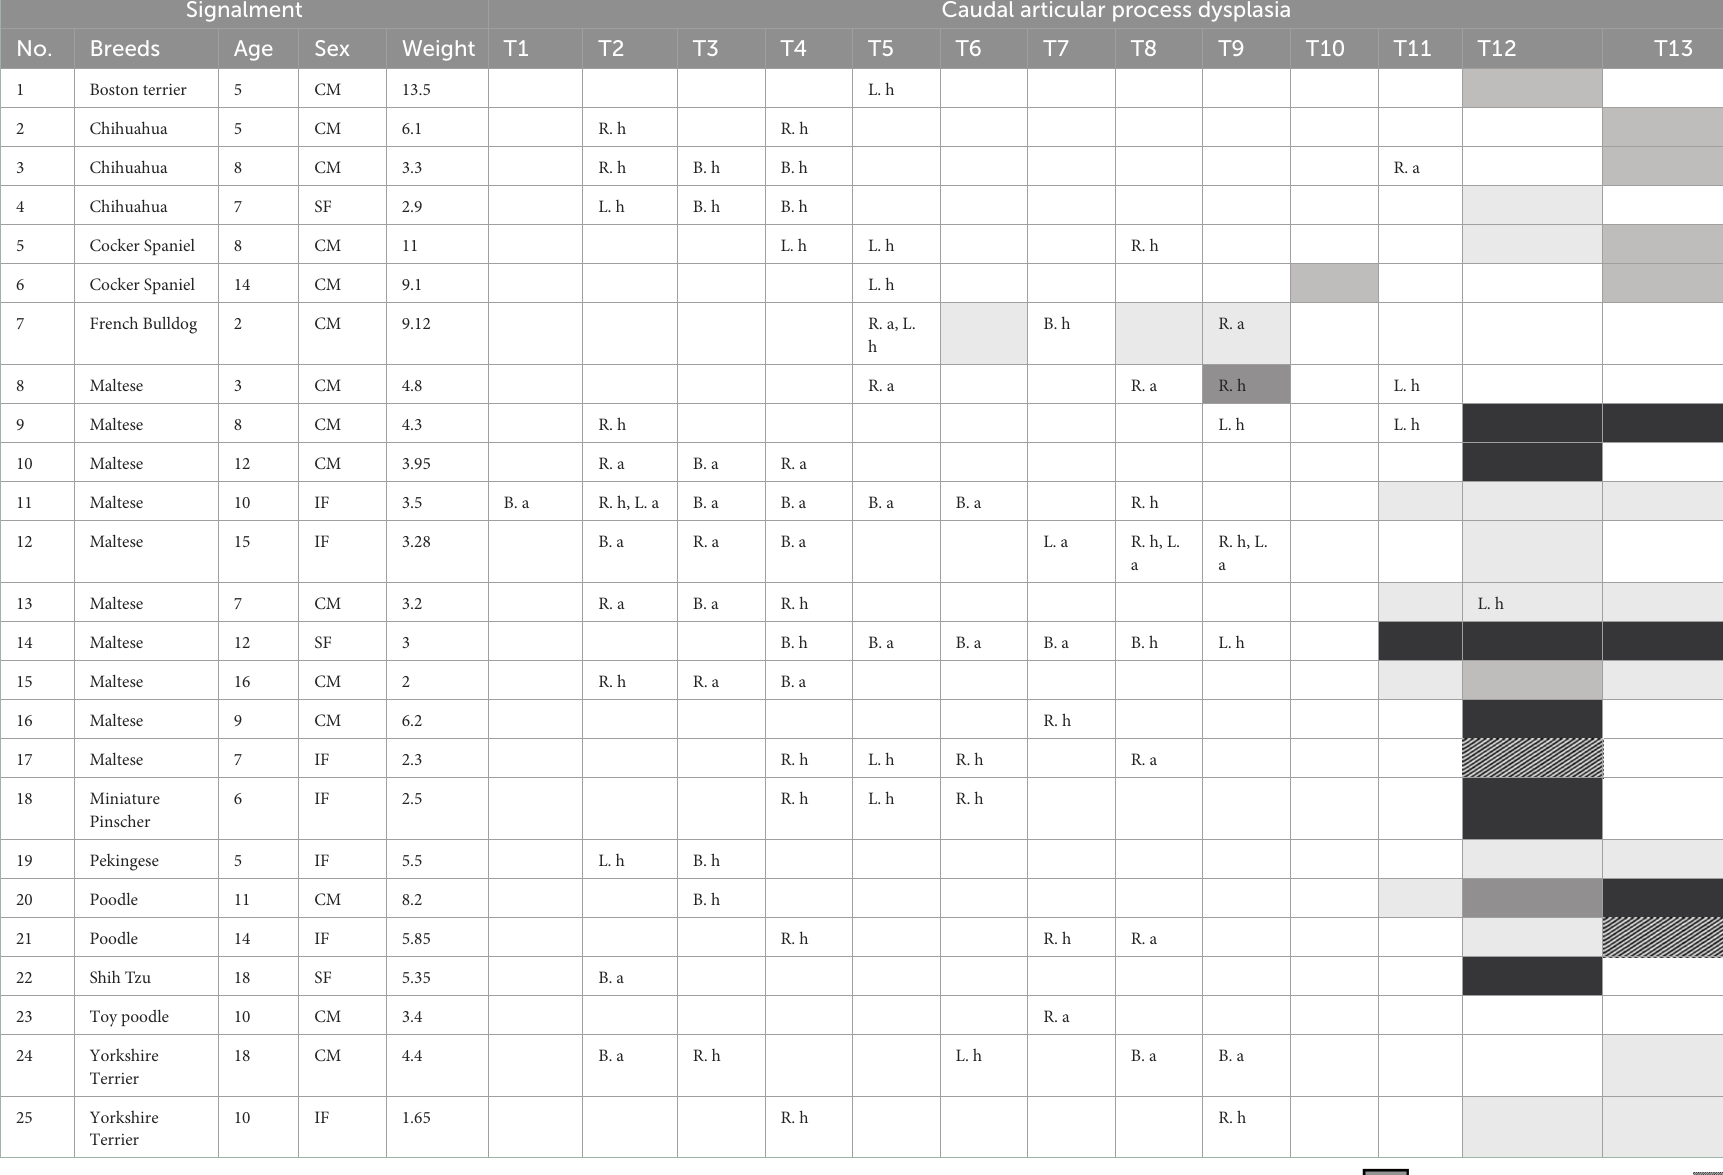
TABLE 4 Characteristics of 25 dogs with caudal articular process dysplasia and spinal cord myelopathy. Signalment Caudal articular process dysplasia